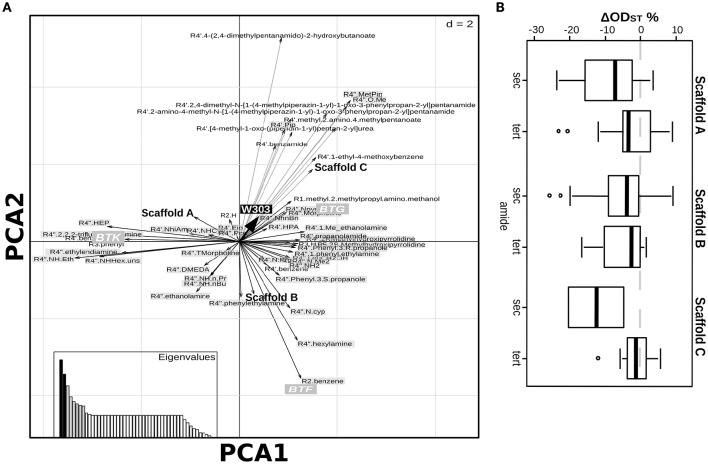
Results of the analysis on the complete library of molecules. (A) Duality diagram for the first two principal components obtained by analyzing the ΔODst % and the chemical features of the complete library of molecules. The cases for analysis were the molecules composing the library. The variables are the ΔODst % induced by the molecules on the W303 strain and the molecule chemical features (substituent types, scaffold types); black-box labels: effects on the tested strains, bold labels: molecules classification as shown in Figure 1A, gray-box labels: molecules classification as shown in Figure 1B. (B) Boxplots representing the influence of the presence of a secondary or tertiary amine in position R4″ in the effects induced on the W303 wild-type strain ODst by the molecules classified in three groups as described in Figure 1A.